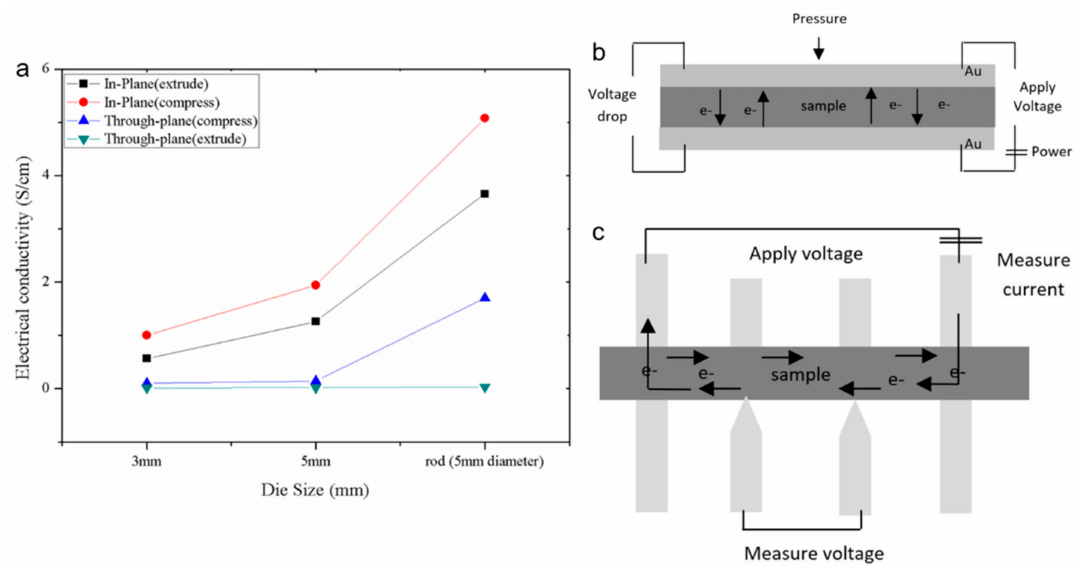
Figure 5. ( a ) Electrical conductivity of extruded and compress MCF/PP, schematic of ( b ) through-plane conductivity and ( c ) in-plane